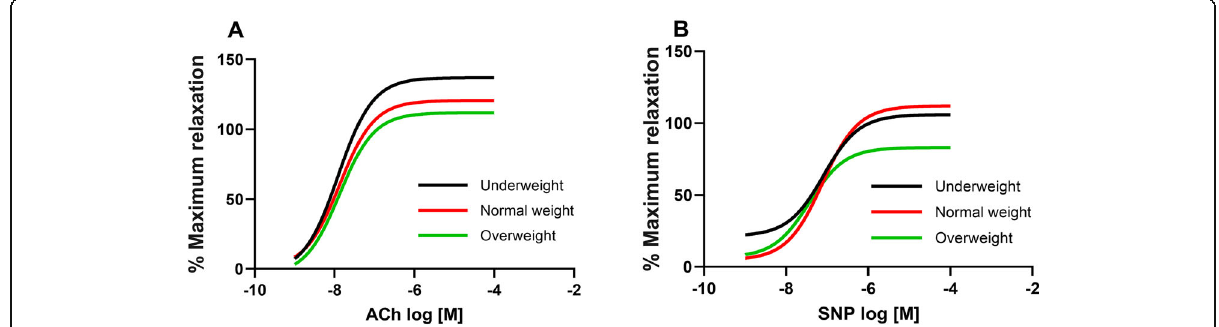
Fig. 3 Vascular relaxation responses in isolated aortic rat rings showing endothelial-dependent relaxation ( a ) and endothelial-independent relaxation ( b ) by body mass index